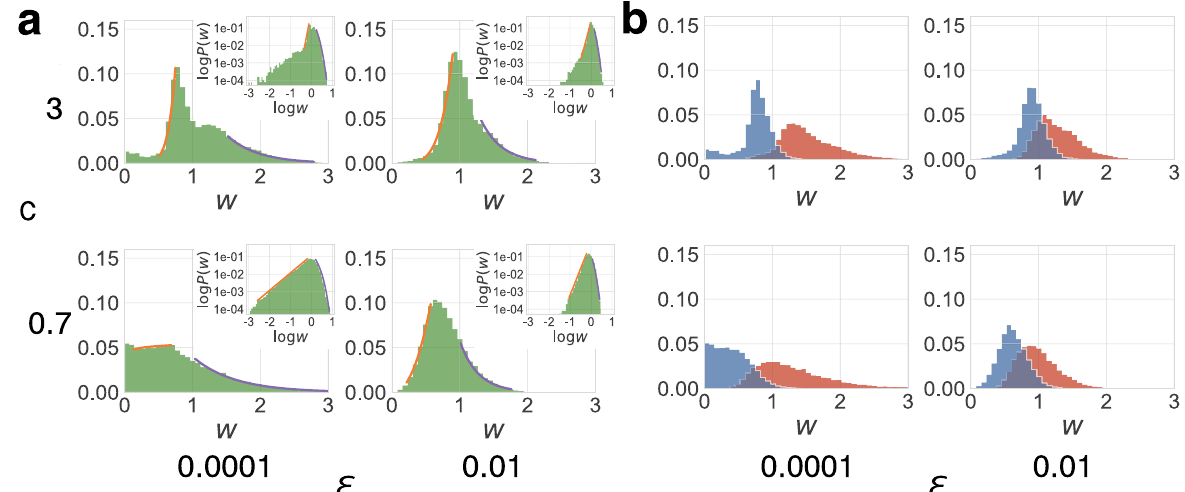
Fig. 5 Distributions of wealth in evolved societies. a The graphs show the frequency distribution of family wealth in the last 1000 steps for environmental conditions with c = 0.7, 3 and ϵ = 0.0001, 0.01. The orange line shows the power-law fi tting, and the purple line shows the exponential distribution fi tting. The insets show the log – log plot of the frequency distribution. b The wealth distribution of the eldest (red) and younger siblings (blue).